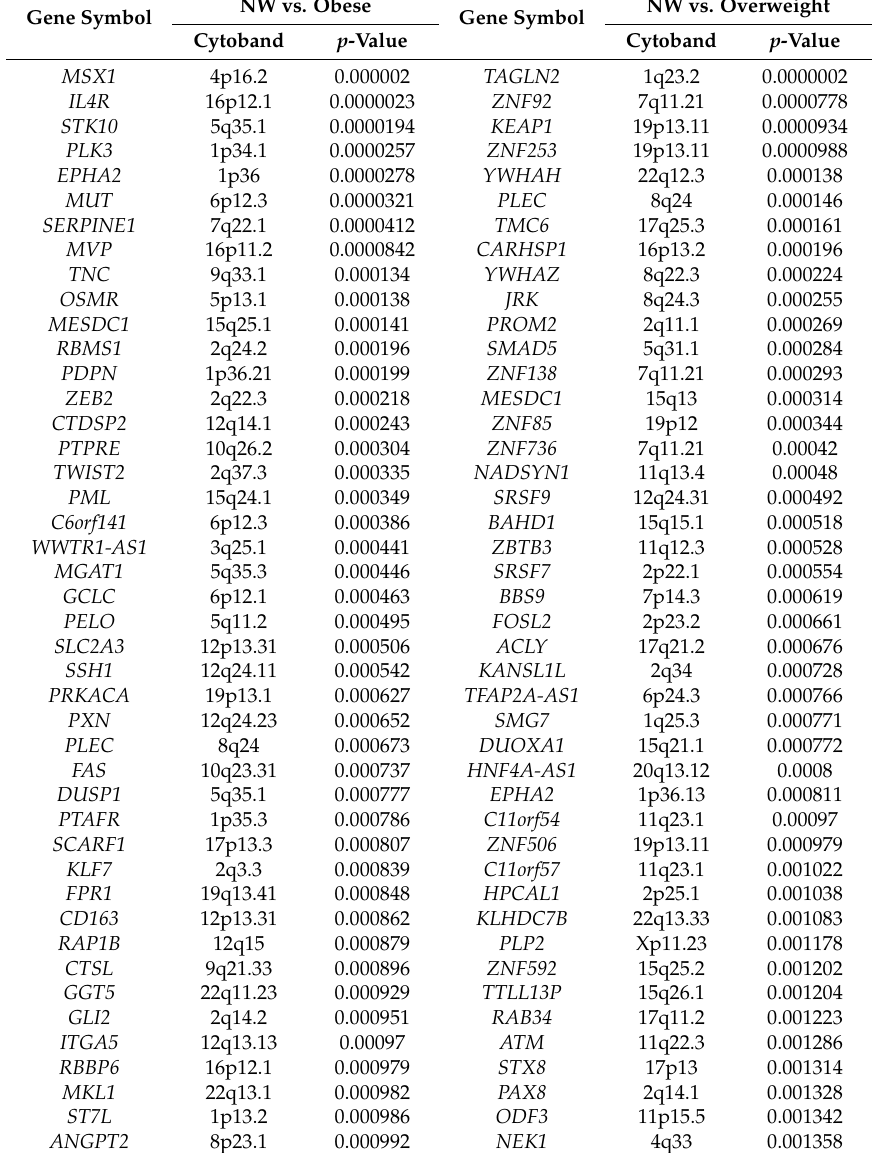
Table 2. Top 44 most highly significantly differentially expressed genes associating obese and or overweight status with TNBC in postmenopausal women. NW = Normal